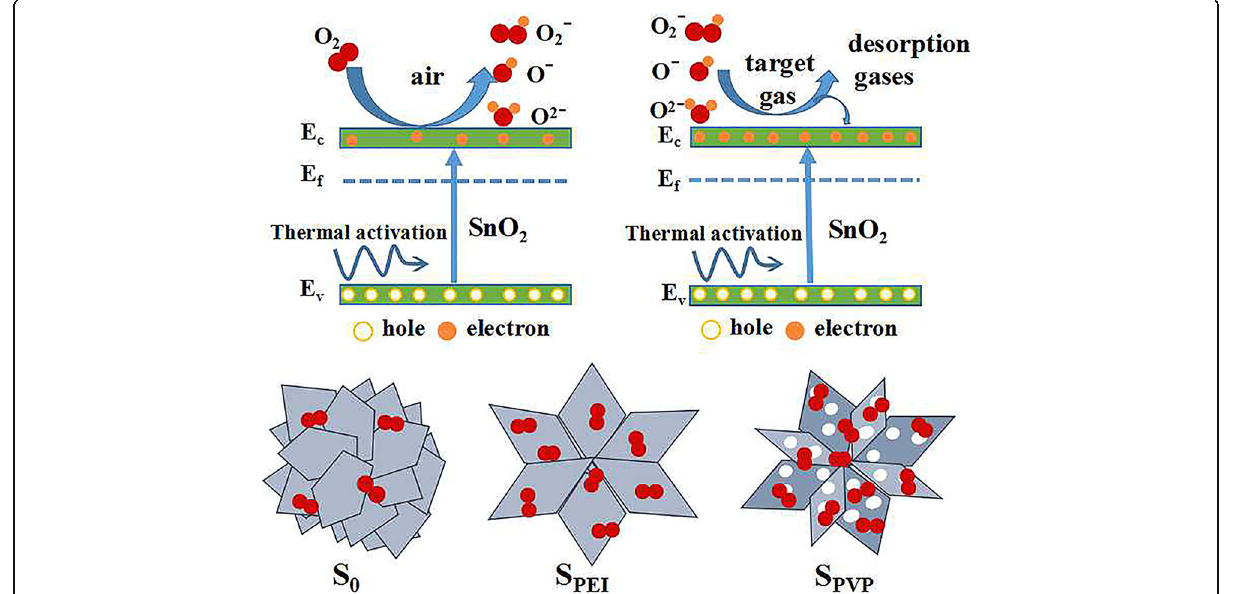
Fig. 10 Schematic diagrams on the gas-sensing mechanism of flower-like SnO 2 hierarchical